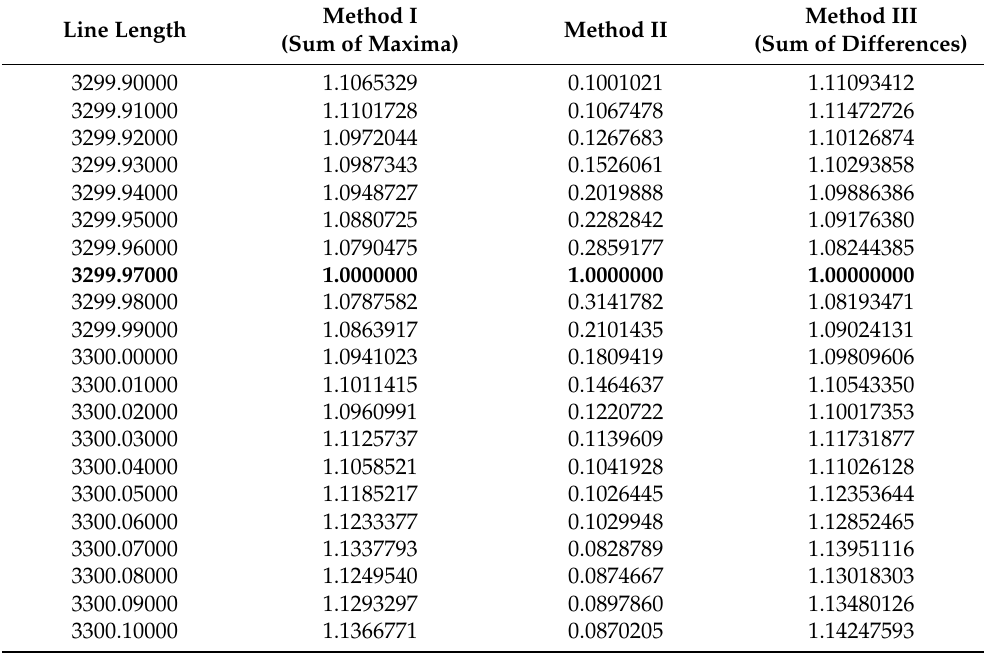
Table 14. Image line length estimation results for the accuracy ∆ =